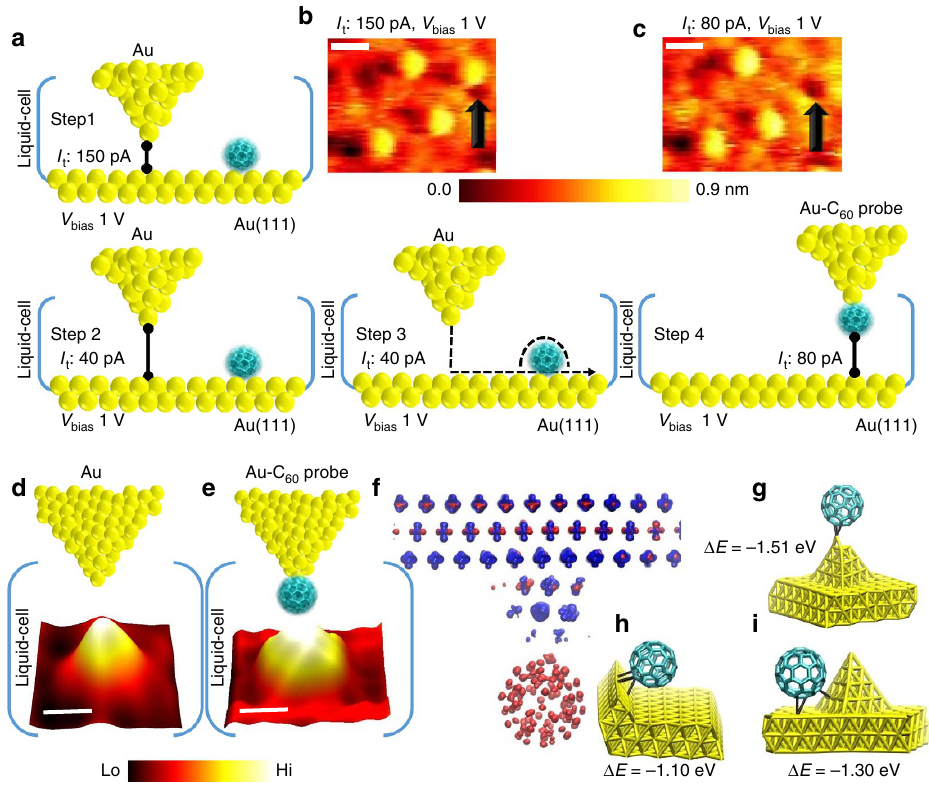
Figure 2 | Fullerene terminated STM probe formation, analysis and electronic structure. ( a ) Schematics detailing the steps involved in formation of a molecular probe by controlled transfer of a surface confined molecule to the apex of the Au probe. ( b ) Constant-current STM image of isolated C 60 molecules adsorbed on Au(111). The molecule marked by the black arrow is selected for the transfer. ( c ) Imaging the same area after the lateral manipulation transfer experiment. The scale bars in b and c are 1.1nm. ( d , e ) Control experiments in which the individual molecule on the surface is imaged using a Au probe ( d ) and C 60 -terminated Au probe ( e ), showing different structural lineshape with the C 60 probe revealing submolecular structure. (Tunnelling parameters for data shown in d and e are I tunnel ( I t ) ¼ 50pA, V bias ( V b ) ¼ 0.5V. The scale bars in d and e are 0.8nm. ( f ) Computed electron density surface for the molecular probe in silicone oil showing electron density maps of the occupied states at the top of the valence band (coloured blue, calculated over the energy range of (cid:3) 1V up to the Fermi energy, set to 0V) and unoccupied states at the bottom of the conduction band (coloured red, calculated in the energy range of 0V to þ 1V). The isovalue used is 0.05 and the atoms are removed for clarity. ( g – i ) Electronic structure calculations of representative bonding sites of the C 60 molecules on nanostructured gold. Au–Au and Au–C distances below 3.2 and 3.0Å are drawn as sticks and C–C distances below 2.0Å are drawn as sticks. D E is the computed C 60 –Au bond